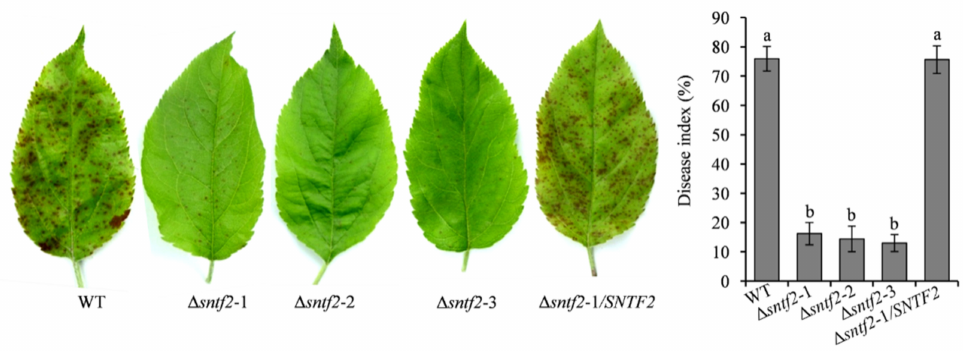
Figure 3. SNTF2 deletion reduced the pathogenicity of Colletotrichum gloeosporioides . The pathogenic- ity was evaluated based on the disease index. Each experiment was repeated three times with ten leaves used for each replicate. Error bars represent standard deviations. Lowercase letters indicate significant differences ( p <